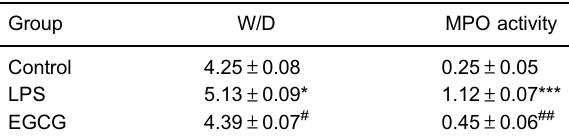
Data are reported as means ± SE. Control group: mice were given saline; LPS group: mice were given lipopolysaccharide (LPS); EGCG group: mice were given epigallocatechin-3-gallate. *P o 0.05, ***P o 0.001 LPS vs Control; # P o 0.05, ## P o